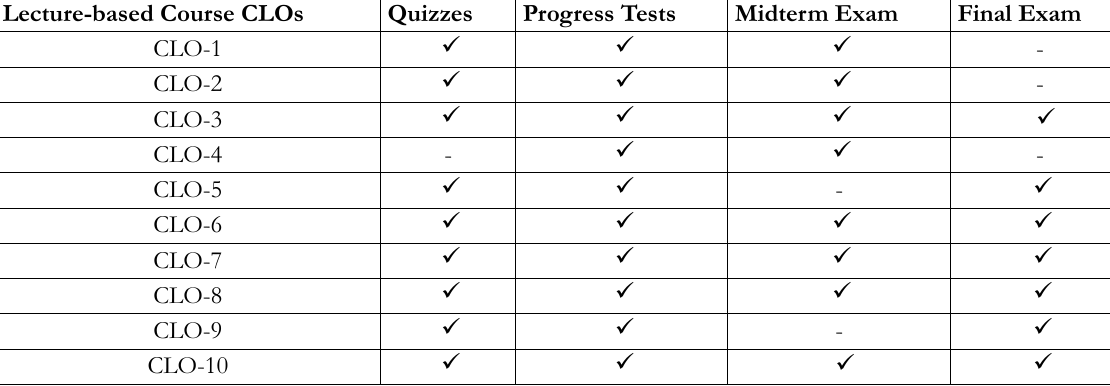
Table 4. The assessment tasks of the lecture-based course mapped to the course learning outcomes Lab Course CLOs Prelab Quest. Oral Quest. Quizzes